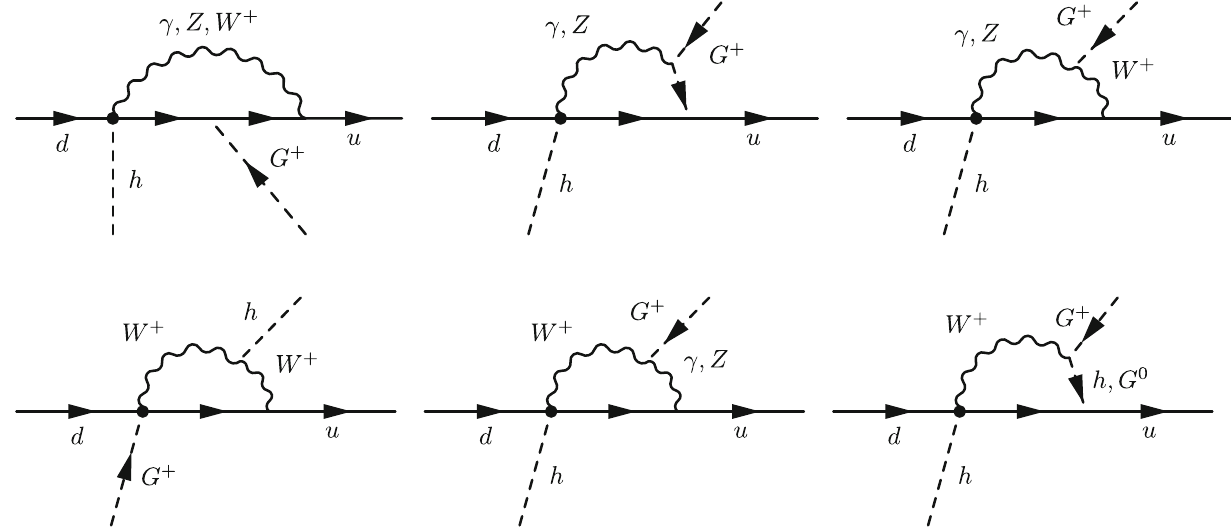
Fig. 17 1PI diagrams contributing to the udhG + 4-point function. We only show the contribution of the down-type dipole. Furthermore, additional diagrams can be generated by exchanging h ↔ G